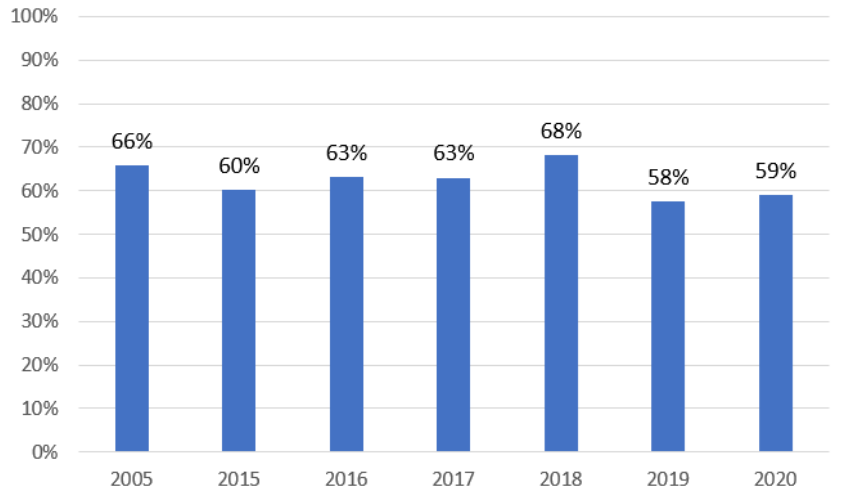
Figure 2. Prevalence of patients with positive mycological tests in the studied years.